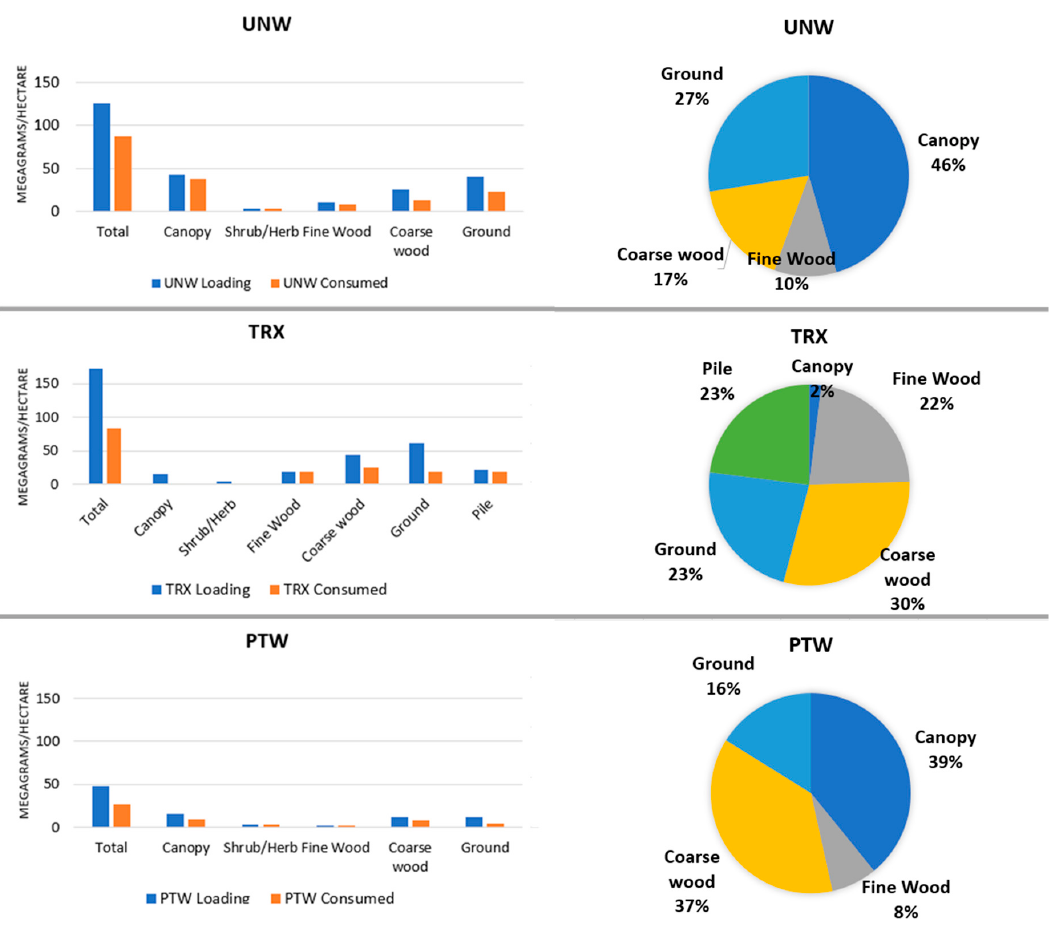
Figure 5. ( Left ) Mean fuel loading and consumption for each scenario. ( Right ) Proportion of the fuelbed contributing to emissions production for ground, woody, and canopy